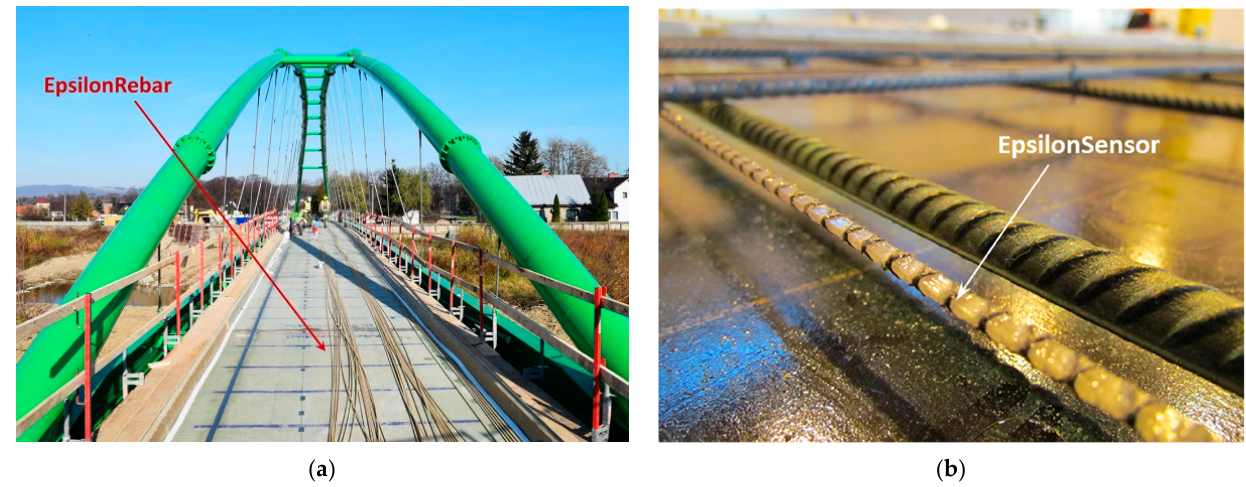
Figure 6. ( a ) Footbridge reinforced with stiff monolithic sensors; ( b ) concrete slab with the flexible